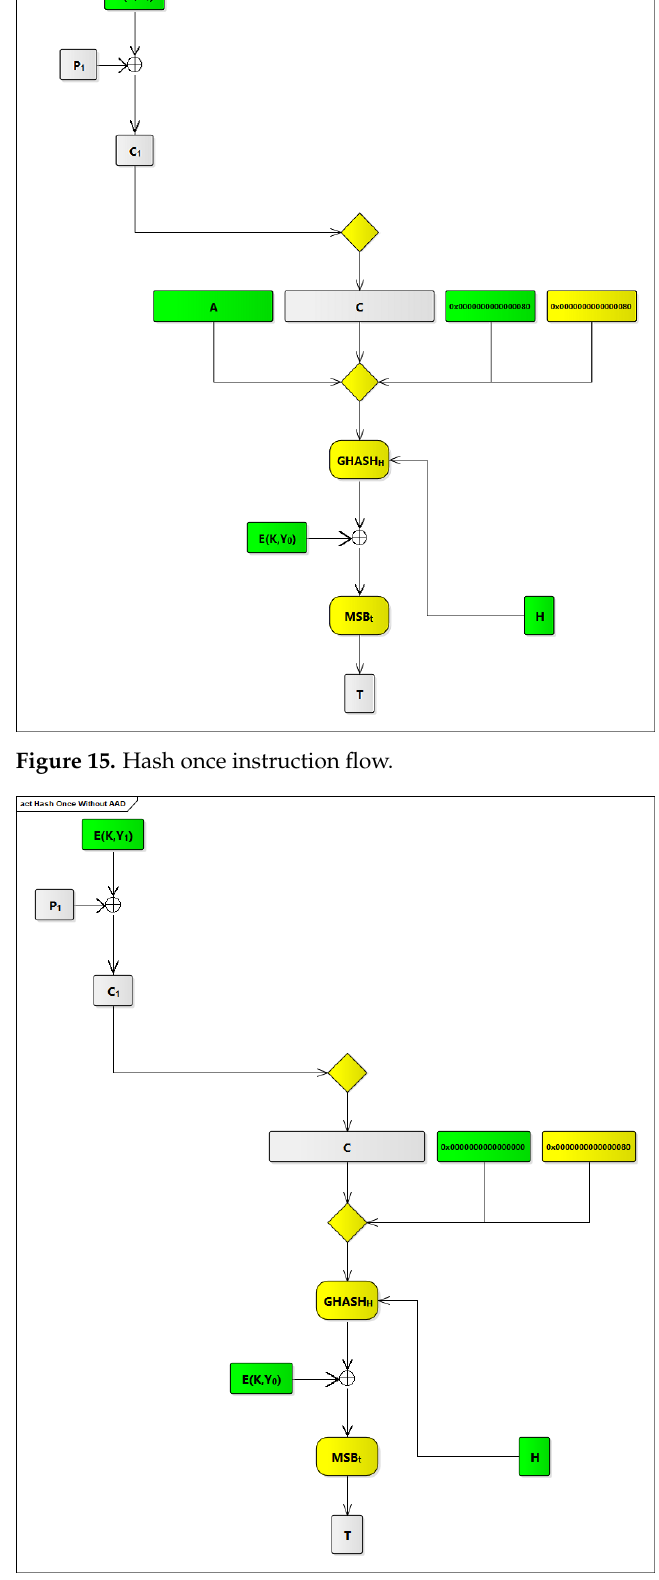
Figure 16. Hash once without